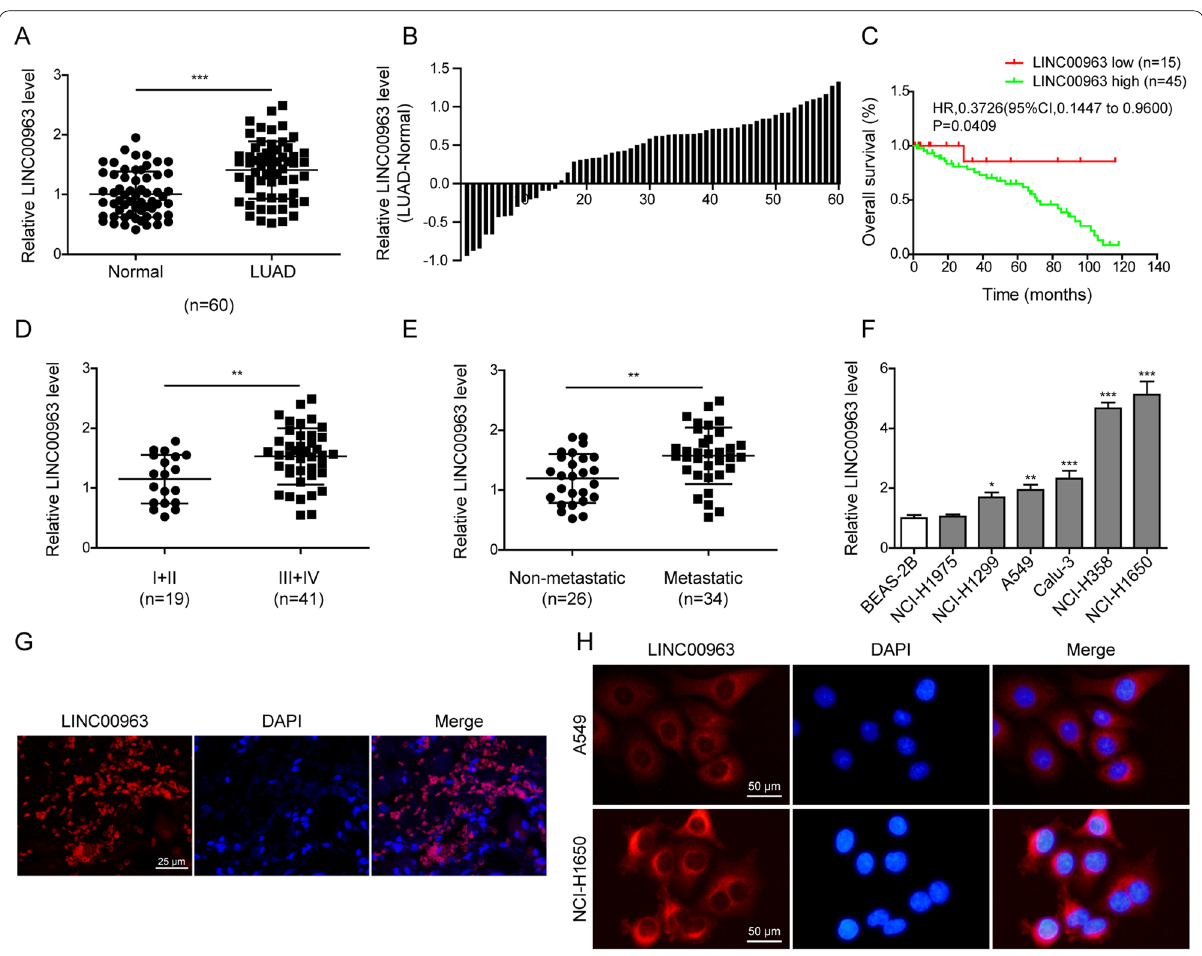
Fig. 1 LINC00963 was up-regulated and positively associated with worse prognosis of LUAD patients. A LINC00963 expression levels were examined by RT-qPCR between 60 pairs of LUAD tissues and matching noncancerous lung tissues. B The expression level of LINC00963 tested in A was presented with each individual patient. C The overall survival was analyzed between LUAD patients presenting high (n LINC00963 expression using Kaplan-Meier method. D LINC00963 expression was compared between LUAD tissues of higher (III lower (I II; n 19) TNM stages. E LINC00963 expression was compared between non-metastatic (n + = F LINC00963 expression was examined by RT-qPCR in lung epithelial cell line BEAS-2B and six LUAD cell lines, NCI-H1975, NCI-H1299, A549, Calu-3, NCI-H358 and NCI-H1650. G , H FISH analysis of LINC00963 in LUAD tissues ( G ), and in A549 and NCI-H1650 cells ( H ). * P < 0.05, ** P < 0.01 and *** P <